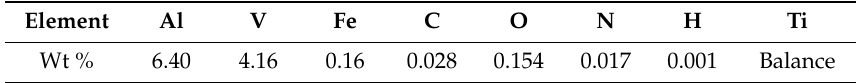
Table 1. Ti6Al4V alloy chemical composition (% by weight).